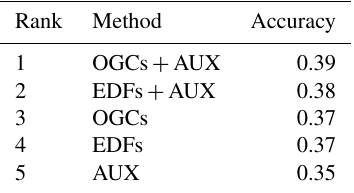
Table 4. Ranks of the accuracies (percent cases correctly predicted) obtained with each method on the eberg dataset. Pairwise t tests showed that differences between the accuracies of the methods were all statistically significant ( p < 0 . 05). AUX – auxiliary data; EDFs – Euclidean distance fields; and OGCs – oblique geographic coor- dinates.